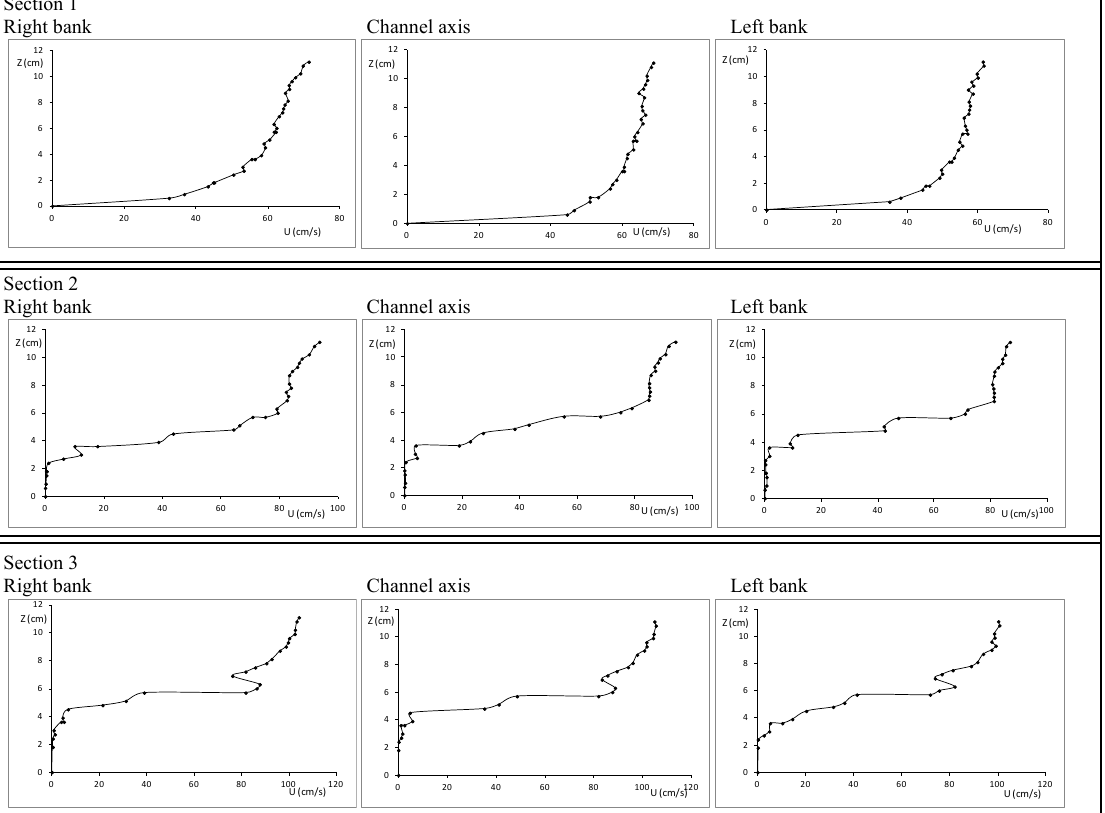
Fig. 7 Vertical profile of the longitudinal velocity – WV